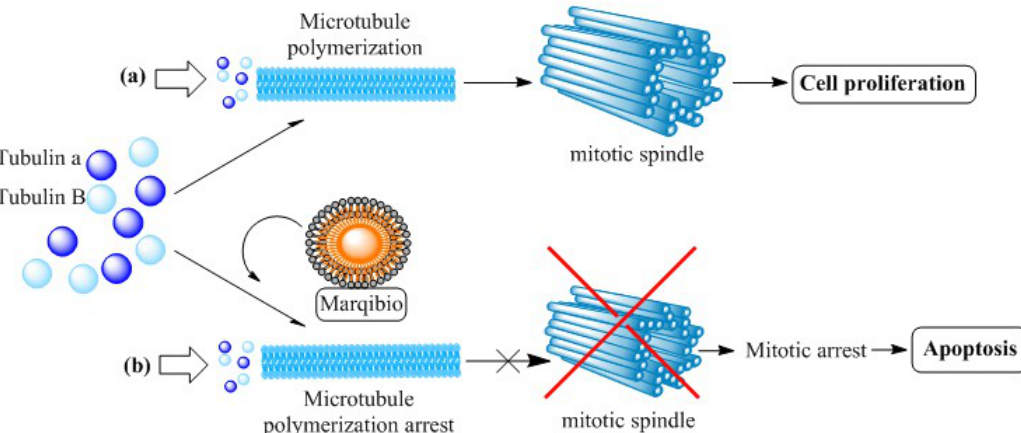
Fig. 2. The effect of Marqibio on microtubule polymerization, (a) cell proliferation in the absence of Marqibio, (b) inhibition of microtubule polymerization in the presence of Marqibio which consequently leads to apoptosis.